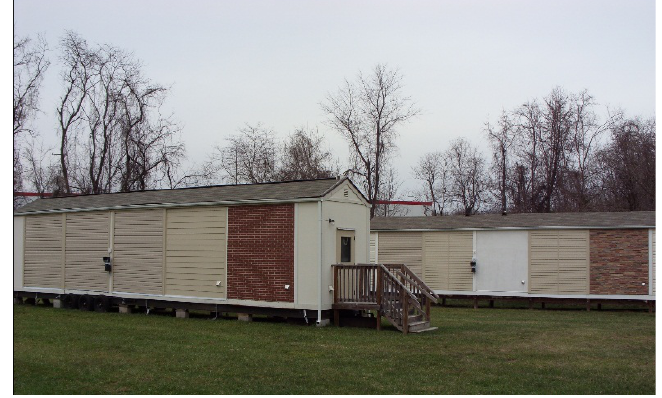
Figure 1. Test structures showing south-facing wall